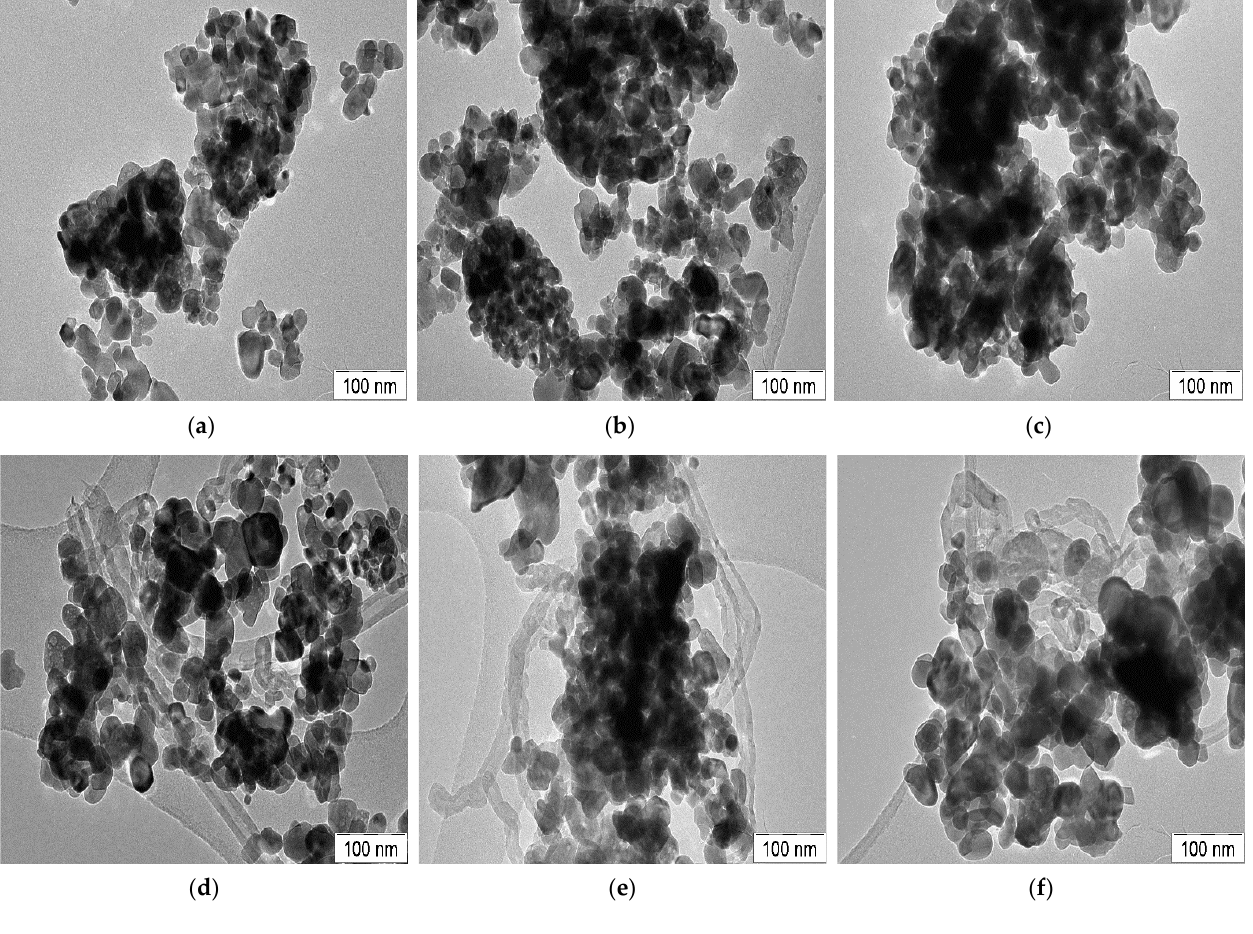
Figure 10. TEM micrographs for fresh ( a ) Sr, ( b ) Ga, and ( c ) Cs and used ( d ) Sr, ( e ) Ga, and ( f ) Cs promoted 5Ni15YZr catalysts at a reaction temperature of 700 °C.